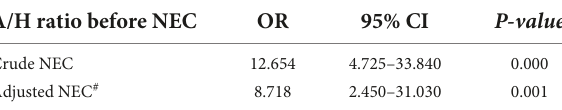
TABLE 4 Association between A/H ratio and NEC analyzed by multiple logistic regression.